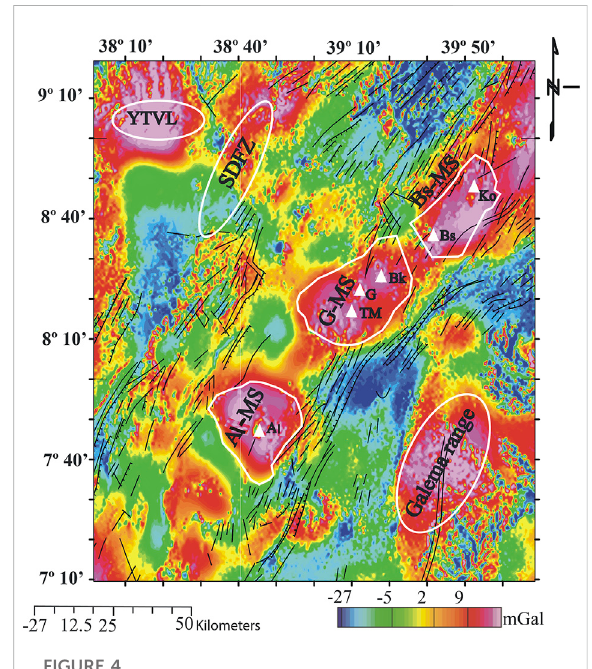
FIGURE 4 The residual gravity anomaly map of the MER was compiled using a high pass fi lter with a cutoff wavelength of 130 km. The elliptical-shaped solid black lines are the off-rift volcanic regions (YVTZ, SDFZ, and Galemarange) and the polygons with white lines are magmatic segments. Labels: Al-MS, G-MS, and Bs-MS represent Aluto, Gedemsa, and Boseti magmatic segments respectively. The overlaid black lines represent faults (where hachured lines are border faults) within the